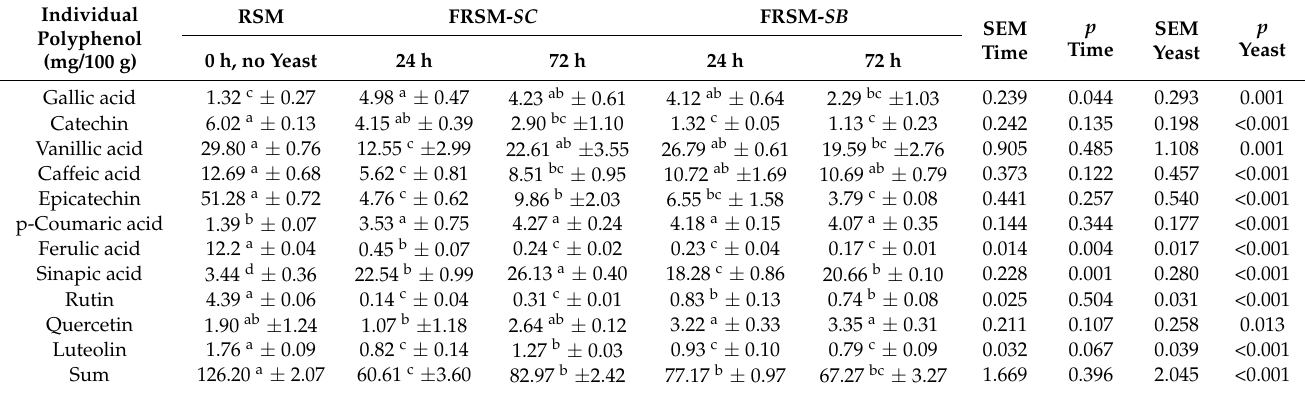
Table 4. Individual phenolic compounds (flavonoids and phenolic acids) in rapeseed meal